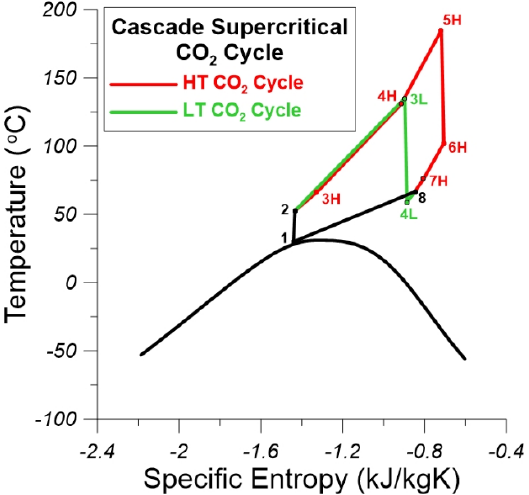
Figure 7. Representation of the cascade supercritical CO 2 cycle at T – s.